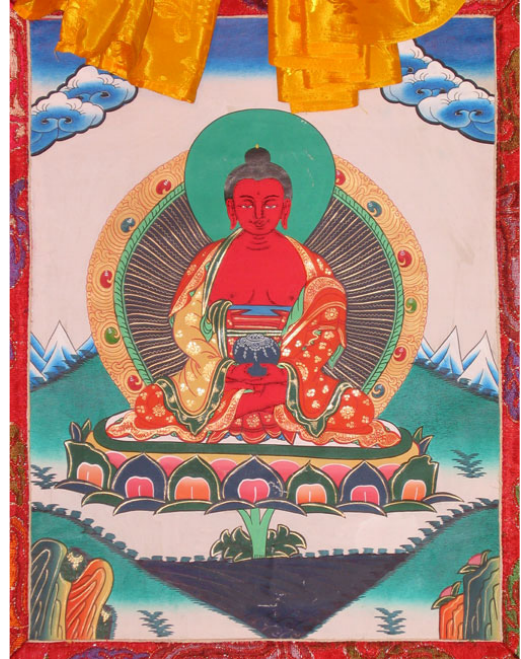
Figure 1. A thangka painting of Amitabha in his Pure